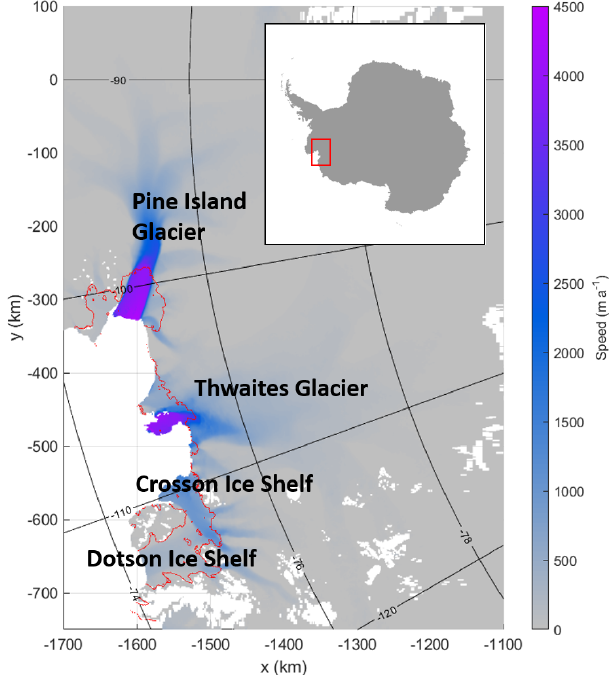
Figure 1. Amundsen Sea Embayment shaded with speed measure- ments from Mouginot et al. (2014). Grounding lines are shown in